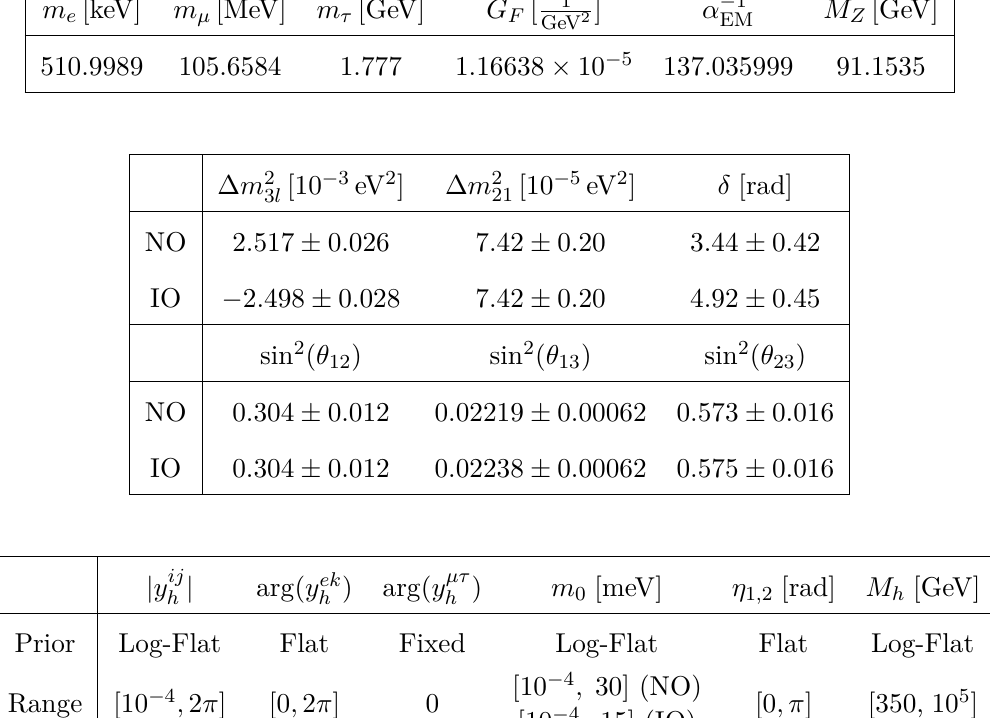
Table 1 . The table at the top contains the experimental values for input parameters taken from [69, 70]; the one in the centre summarises the experimental values for leptonic mixing parameters and neutrino-mass-squared differences taken from NuFIT 5.0 [71]. ∆ m 2 for IO. Priors and the ranges sampled over in the numerical scan are given in the bottom